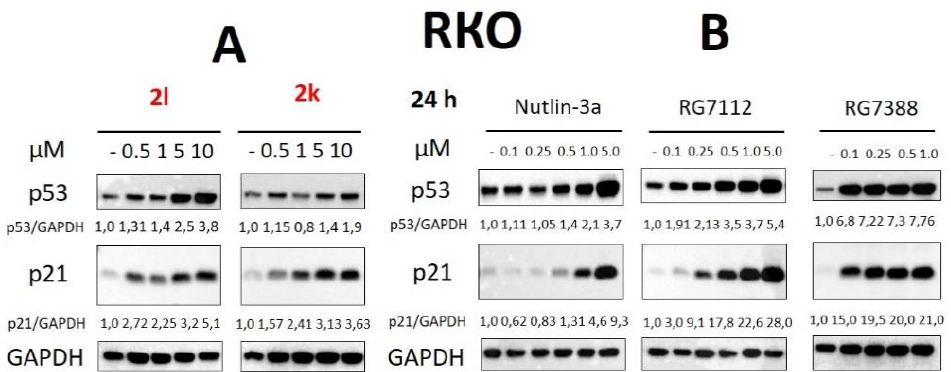
Figure 4. ( A ). Western Blot analysis of total cellular lysates from RKO cells upon the treatment with compounds 2l , 2k (both—20 µ M), Nutlin-3a (10 µ M) and RG7388 (5 µ M). ( B )—Densitometric analysis of p53 bands normalized to GAPDH. Data are presented as mean +/ − SD from three independent experiments. ( C )—The histograms of flow cytometry (FC) analysis data for RKO cells: sub-G1 assay (up), %—percent of Sub-G1 population and Annexin V-FITC/PI staining (below), % viable cells—cells negative for both Annexin V-FITC and propidium iodide (PI). Data from n = 3 biological replicates are shown as mean ± s.d., * p < 0.05, n.s.—not significant. PARP—poly (ADP-ribose)-polymerase; bands normalized to GAPDH, h—hours, N—Nutlin-3a (10 µ M), R—RG7388 (5 µ M).